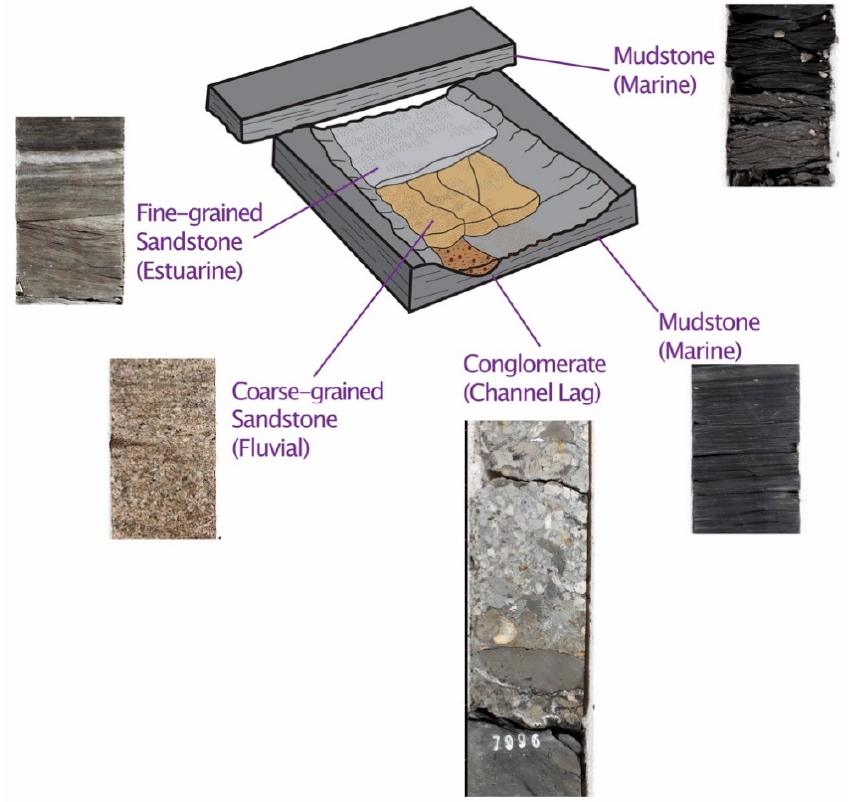
Figure 4. Generalized sequence of depositional environments and lithofacies seen in all Morrow B and B1 cores. All core slabs in the image are approximately 10 cm wide. Conglomerate slab image is approximately 22 cm in